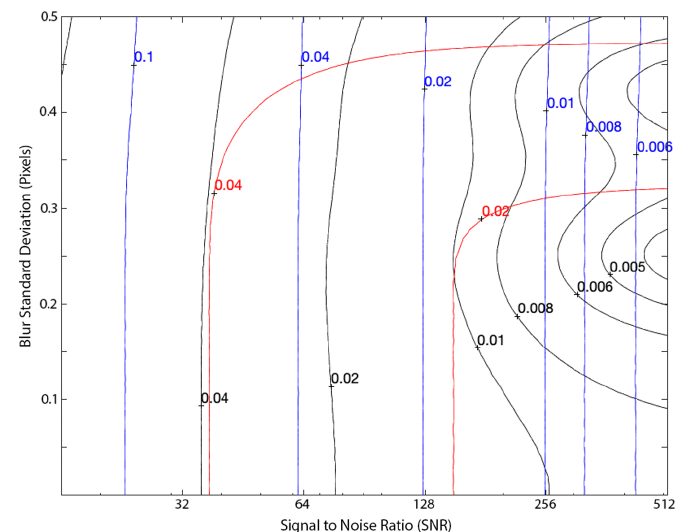
Figure 5. Contours of edge localization error (in pixels, assuming a 5 method from Equation (41) (black), the step function approximation using Zernike moments (red) [11], and the partial area effect (blue) [13] as a function of SNR and blur. Error statistics are computed from a Monte Carlo analysis consisting of 5000 randomized images at each SNR and blur combination.